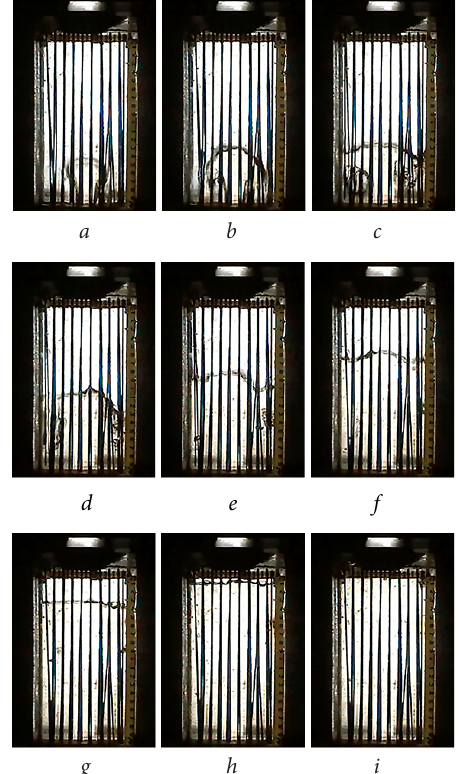
Fig. 5. Video frames of model cavity filling with a reinforcing phase: a – c – initial stage; d – f – steady state stage; g – i – end of